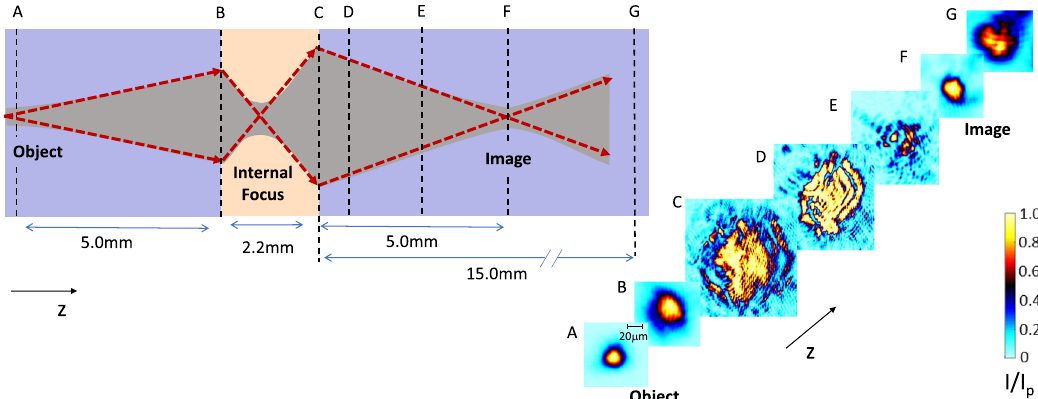
Fig. 4 Superlensing through a KTN sample. A Intensity distribution of the beam at its minimum width (`object', 20 μ m FWHM) 5 mm from the sample facet, B distribution at sample input facet, C at the sample output plane after the topological transition, 2.2 mm from the input facet, D 0.5 mm from the output facet, E 2.5 mm from the output facet, F 5 mm from the output facet (`image', 20 μ m FWHM), and G 10 mm from the